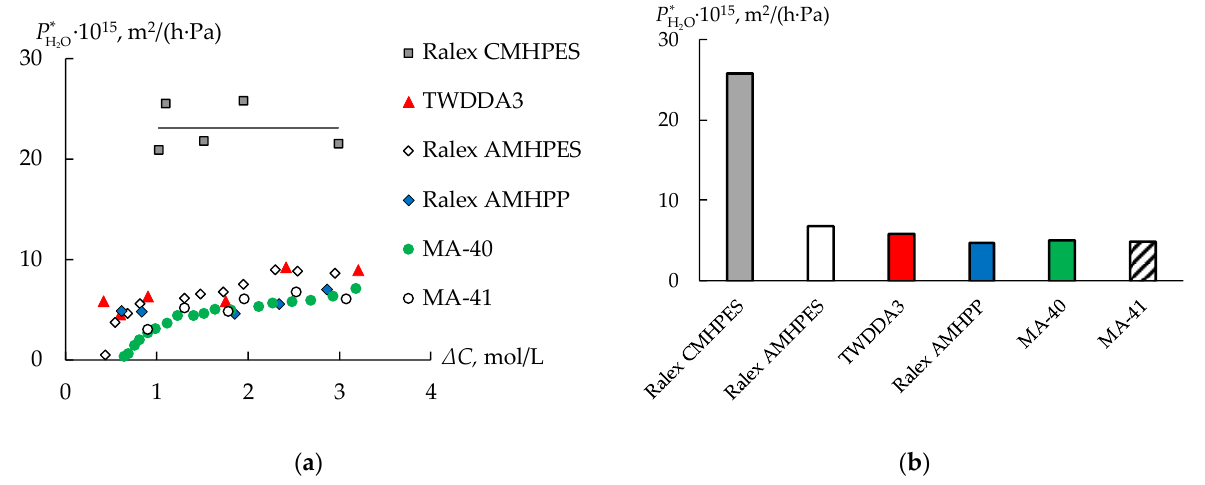
Figure 7. Water permeability coefficient of the membranes depending on the concentration difference ( a ) and values of the membranes water permeability coefficient at Δ С = 1.75 mol/L ( b ). Comparison of the water permeability of AEMs shows that the dialysis TWDDA3 membrane and Ralex AMHPES membrane have a slightly higher permeability than others. However, the values of the water permeability of all AEMs are similar. The total water flux through the cation- and anion-exchange membranes has the opposite direction. It